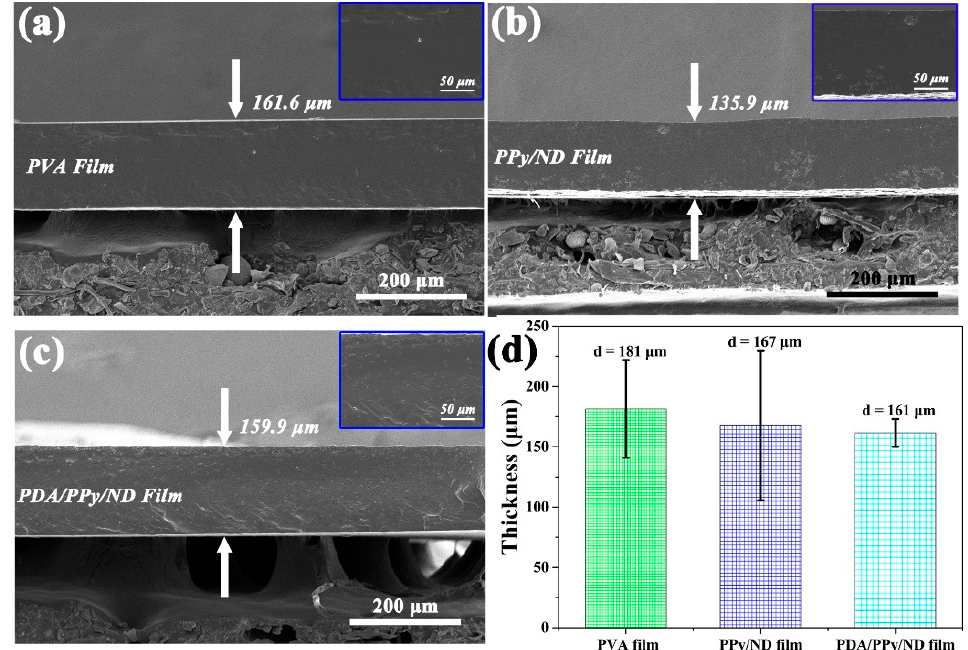
Figure 8. The SEM images of the film cross sections: ( a ) PVA film, ( b ) PPy/ND film and ( c ) PDA/PPy/ND film; the insert images in ( a – c ) were the related local enlarged SEM images, and ( d ) the film thicknesses measured by the spiral micrometer.